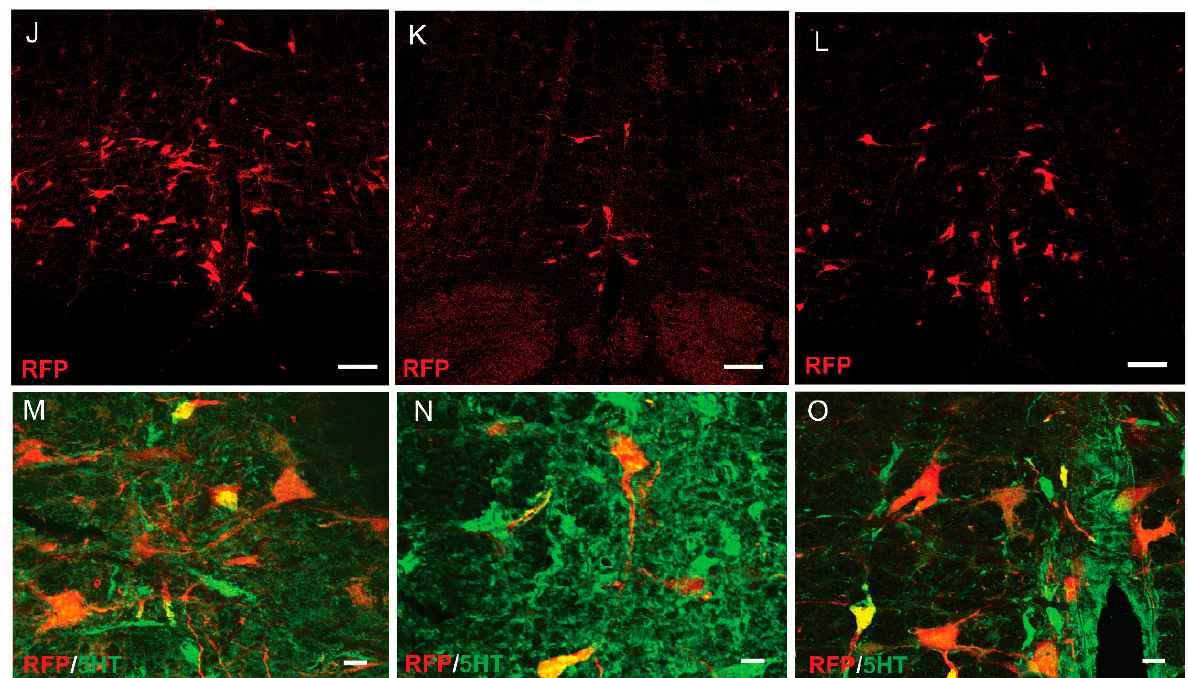
Figure 8. Locomotor exercise enhances supraspinal-EUS motoneuron neural circuit. ( A ) Coronal section of the brain with locations of raphe nuclei (red box area) where imaging and quantification were performed. ( B , C ) Number of c-fos positive cells and red fluorescence protein (RFP)-labeled neurons in SCI without exercise group were significantly less than those in the sham and exercise groups. These results indicate that exercise training recruited more supraspinal neurons to control EUS function evidenced by more activated brain stem neurons during urodynamic experiment. ( D – F ) Immunofluorescence staining showing c-fos positive cells in coronal section of the brain. ( G – I ) Some (green arrow) but not all c-fos positive neurons (red arrow) are serotoninergic (c-fos + , red; 5-HT + , green). Subgroup of rats was injected with pseudorabies virus expressing RFP into the EUS. At 72h after injection, photomicrographs from coronal section of the brain demonstrate that RFP-labeled neurons were detected in the brainstem ( J – L ). ( M – O ) Some (green arrow) but not all of the RFP-labeled neurons (red arrow) are serotoninergic (RFP + , red; 5-HT + , green). Result of negative control from primary antibody omission presented as a Supplementary Figure S1. Scale bars are 100 µ m in ( D , E , F , J , K , L ); 20 µ m in ( G , H , I , M , N , O ). *: p < 0.05; **: p < 0.01; ***: p <